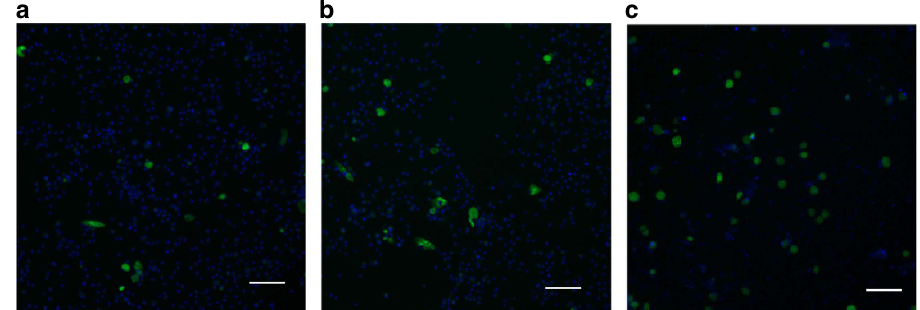
Figure 3 | In vitro infection of mammalian cells with GFP-tagged C. trachomatis harvested from 48h infections. ( a ) Human iPSdMs. ( b ) Human blood monocyte-derived macrophages. ( c ) McCoy epithelial cells. Representative images were taken using the Cellomics CellInsight NXTat (cid:3) 10 magnification, scale bar, 80 m